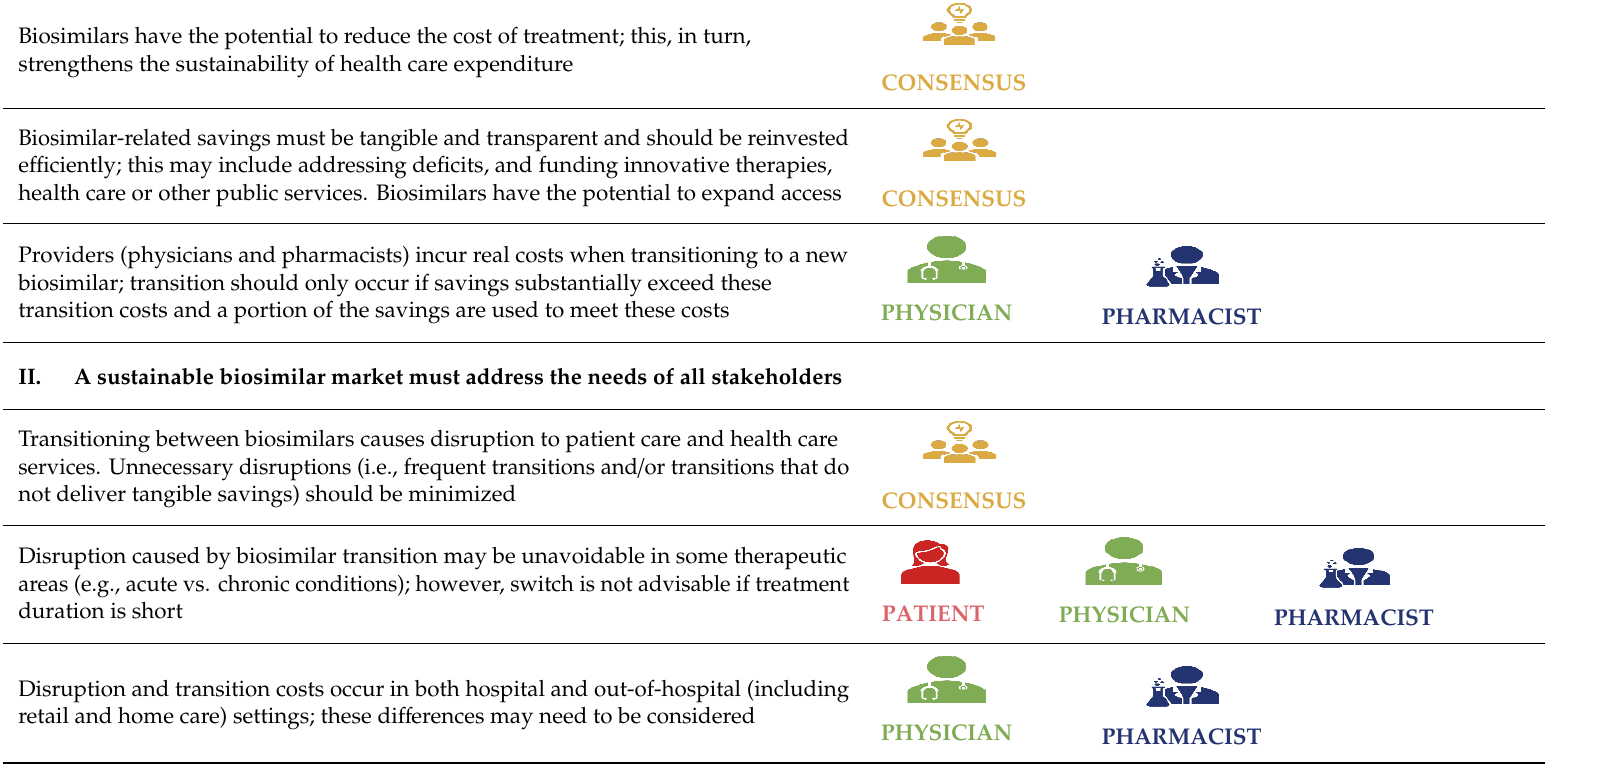
Table 1. Consensus on components of a sustainable biosimilar market.